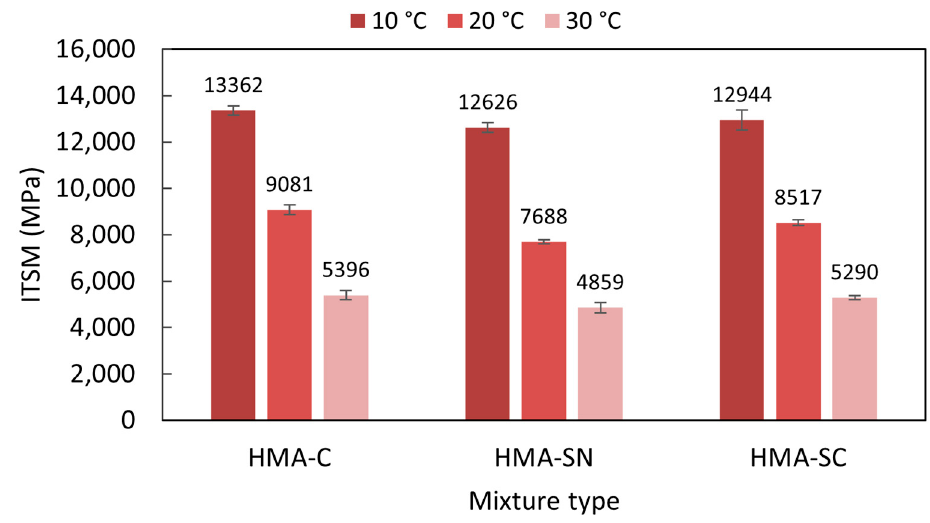
Figure 7. ITSM for the HMA mixtures.